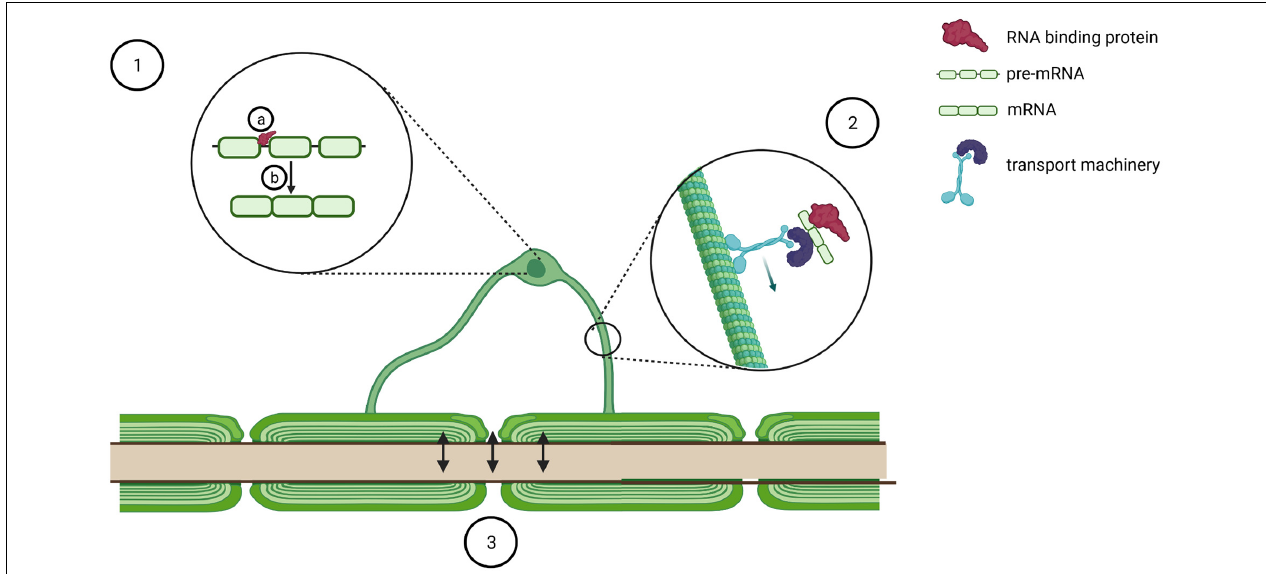
FIGURE 2 | Schematic of potential mechanisms of oligodendrocyte dysfunction in pathogenesis of TDP-43/FUS proteinopathies. TDP-43 and FUS pathology in oligodendrocytes might modulate oligodendrocyte biology by binding to several transcripts (1a) and regulating pre-mRNA splicing (1b). Furthermore, it might affect transport of key RNA transcripts such as Mbp (2) and perturb bidirectional communication with axons (3). Created with